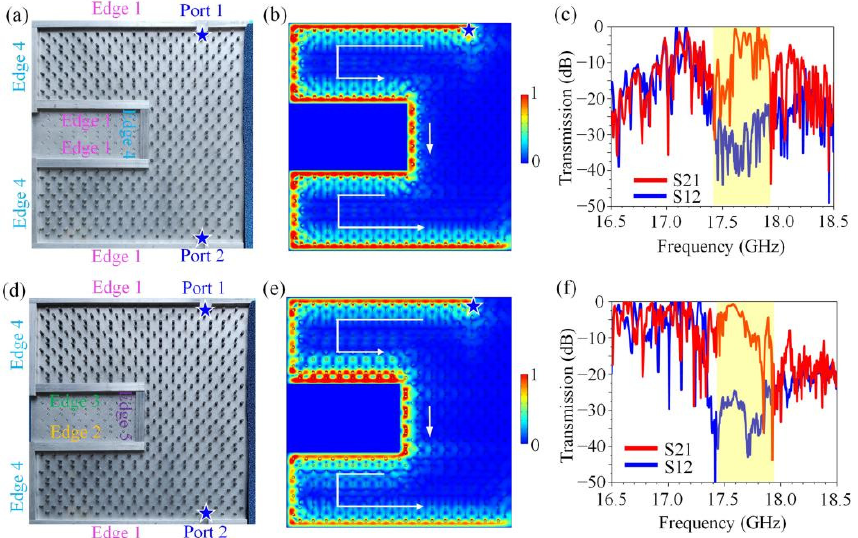
Figure 5. Topological transmission lines composed of Edges 1–5. ( a , d ) Photos of experimental samples. The metallic strips were placed near the boundaries of GPC to form the transport channels, and the microwave absorbers were utilized to avoid the reflection of EM waves. ( b , e ) Simulated electric field distributions excited by a line source. The blue star is the line source and the white arrow indicates the direction of electric field transmission. ( c , f ) Measured transmission spectra of topological resistance-free transmission lines. There existed a big contrast (about 30 dB) between parameters S21 and S12 at 17.45~17.95 GHz.